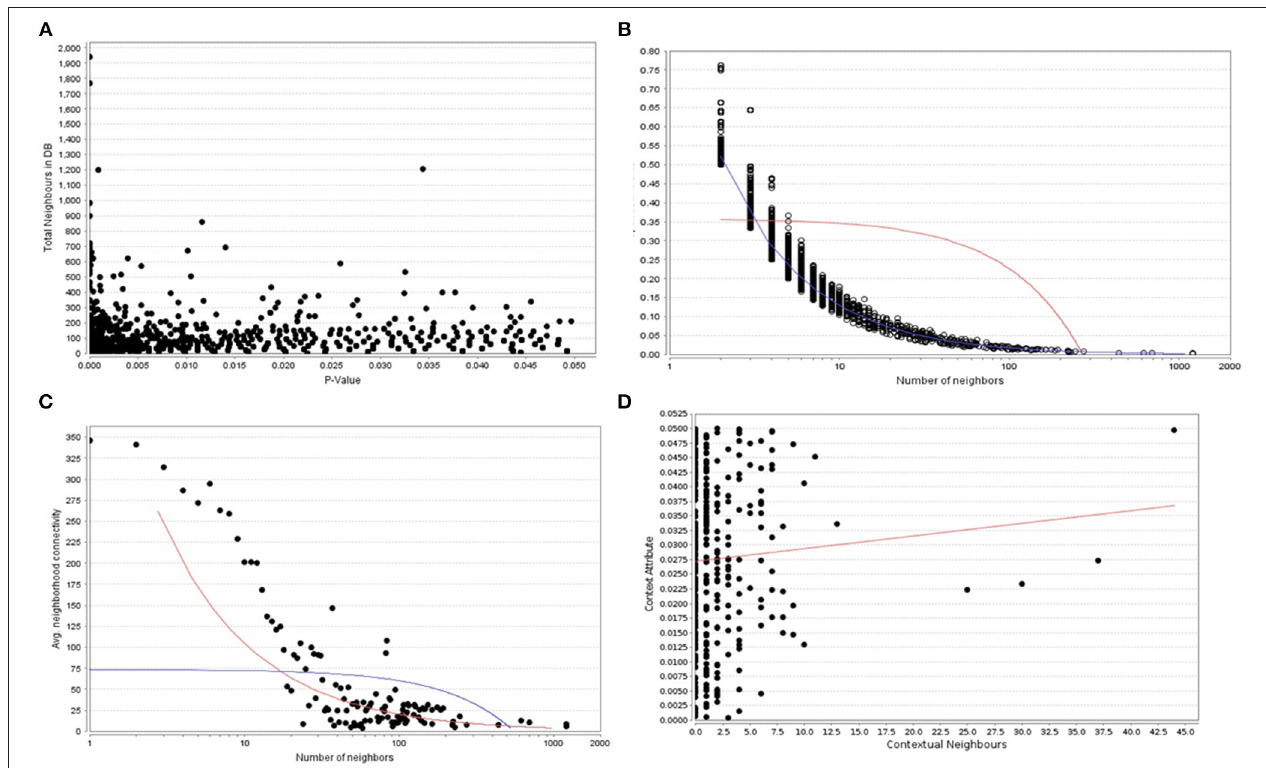
FIGURE 2 | (A) The P -values plotted against the total neighboring DEGs, (B) The number of neighbors mapped to the total coefficients, (C) The number of distinct neighbors against the average neighborhood connectivity from DEGs, and (D) contextual neighbors plotted against the contextual